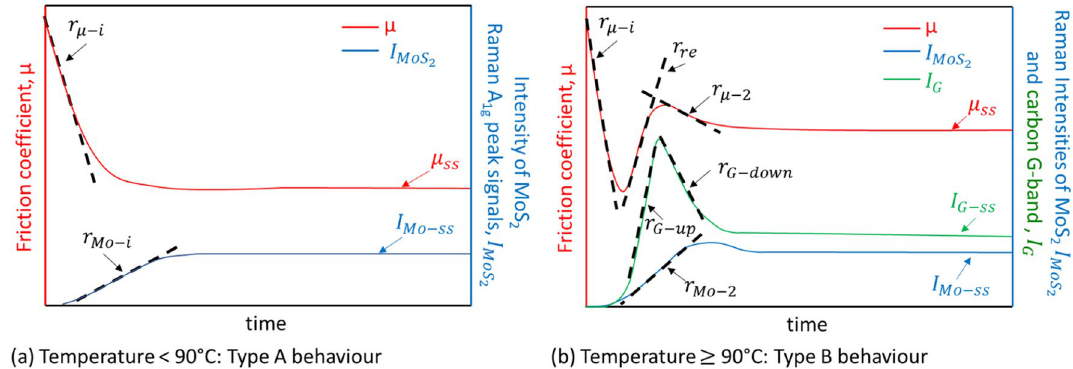
Figure 2. Typical friction curves and time-resolved MoS 2 and carbon Raman signals indicating how the different rates are defined for test performed at: ( a ) T < 90 °C—type A case; and ( b ) T ≥ 90 °C–—type